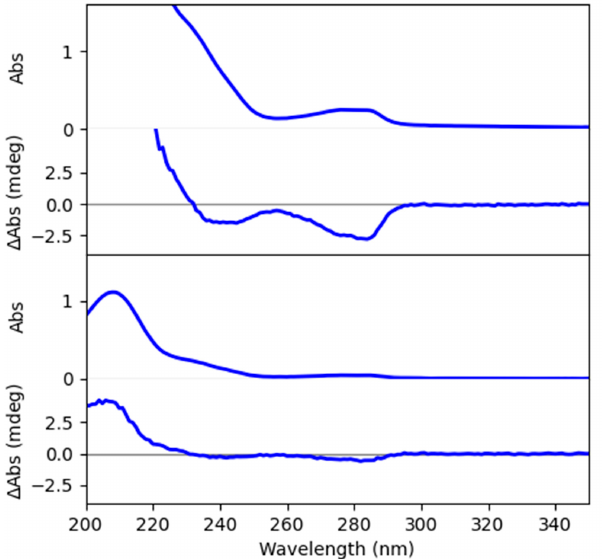
Figure 7. UV and ECD spectra of the mixture of compounds 1 and 2 . Top: spectra recorded for a high concentrated sample. Bottom: spectra recorded for a low concentrated sample.